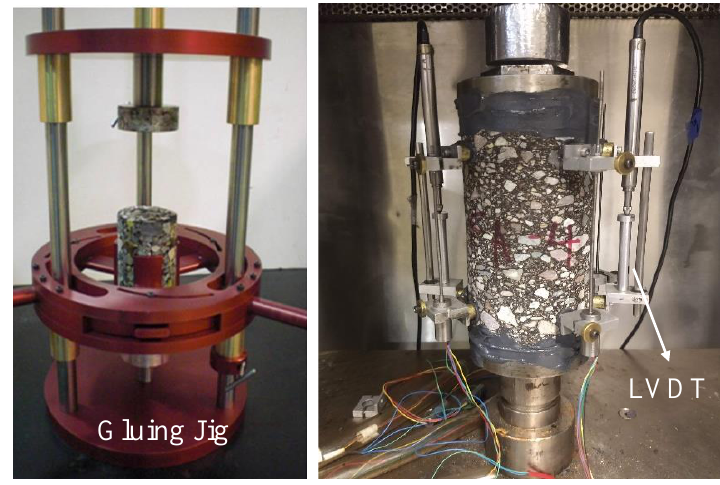
Figure 3. Gluing jig and the uniaxial fatigue test setup.